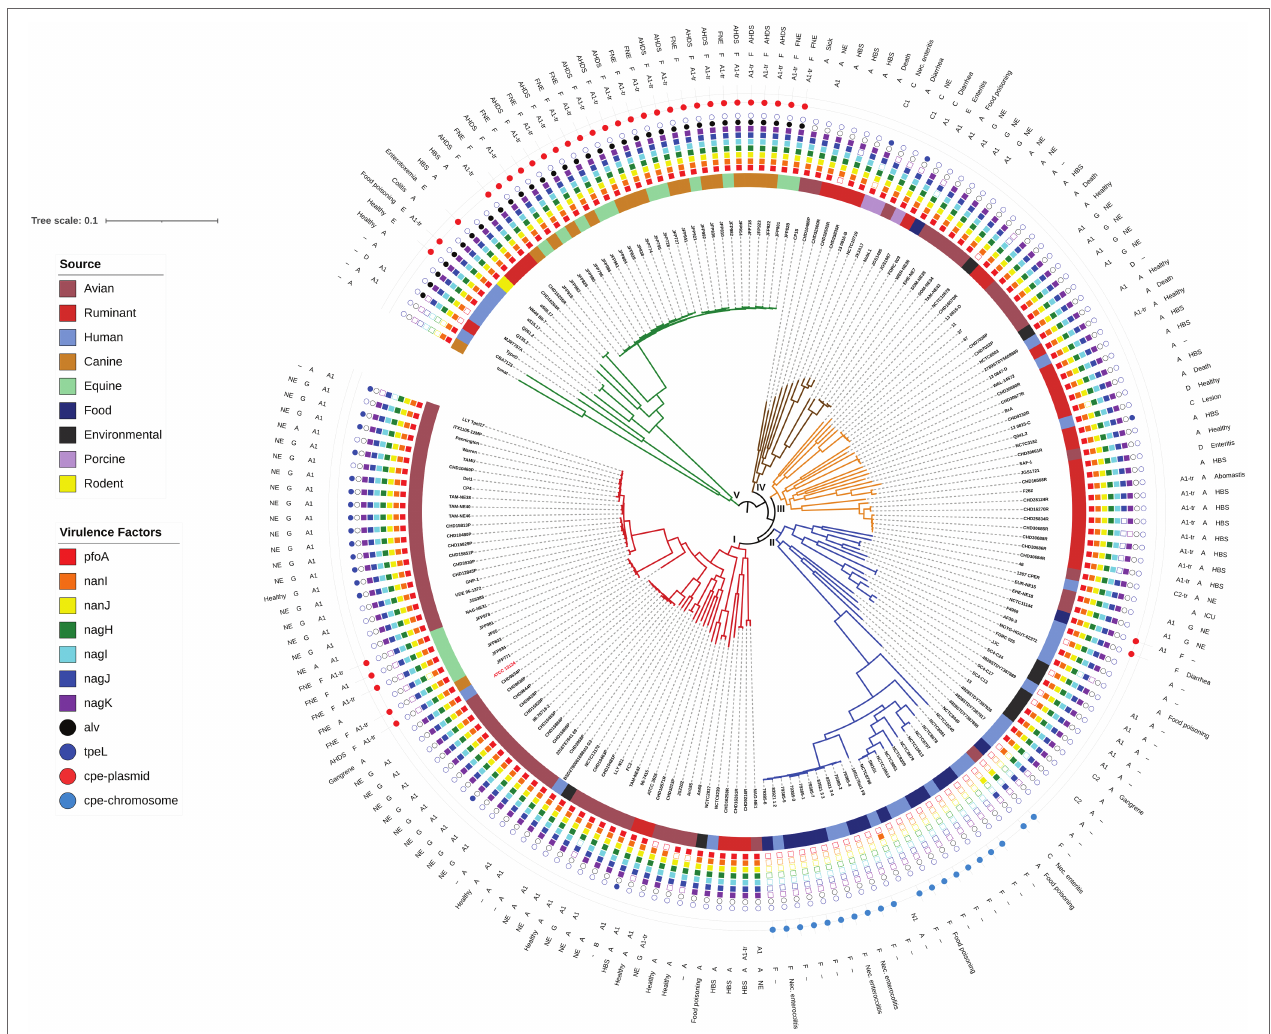
FIGURE 1 | Maximum likelihood phylogenetic tree of C. perfringens genome assemblies determined by single nucleotide polymorphisms compared to the reference strain ATCC 13124. The reference strain and Clade I are shown in red. Clade II is the food poisoning associated clade and Clade V is the alveolysin clade. Host associations are shown on the inner ring, followed by specific virulence factors, the outer three rings indicate the beta2 variant, toxinotype, and health or disease association (if known) of each strain. The tree is rooted at the